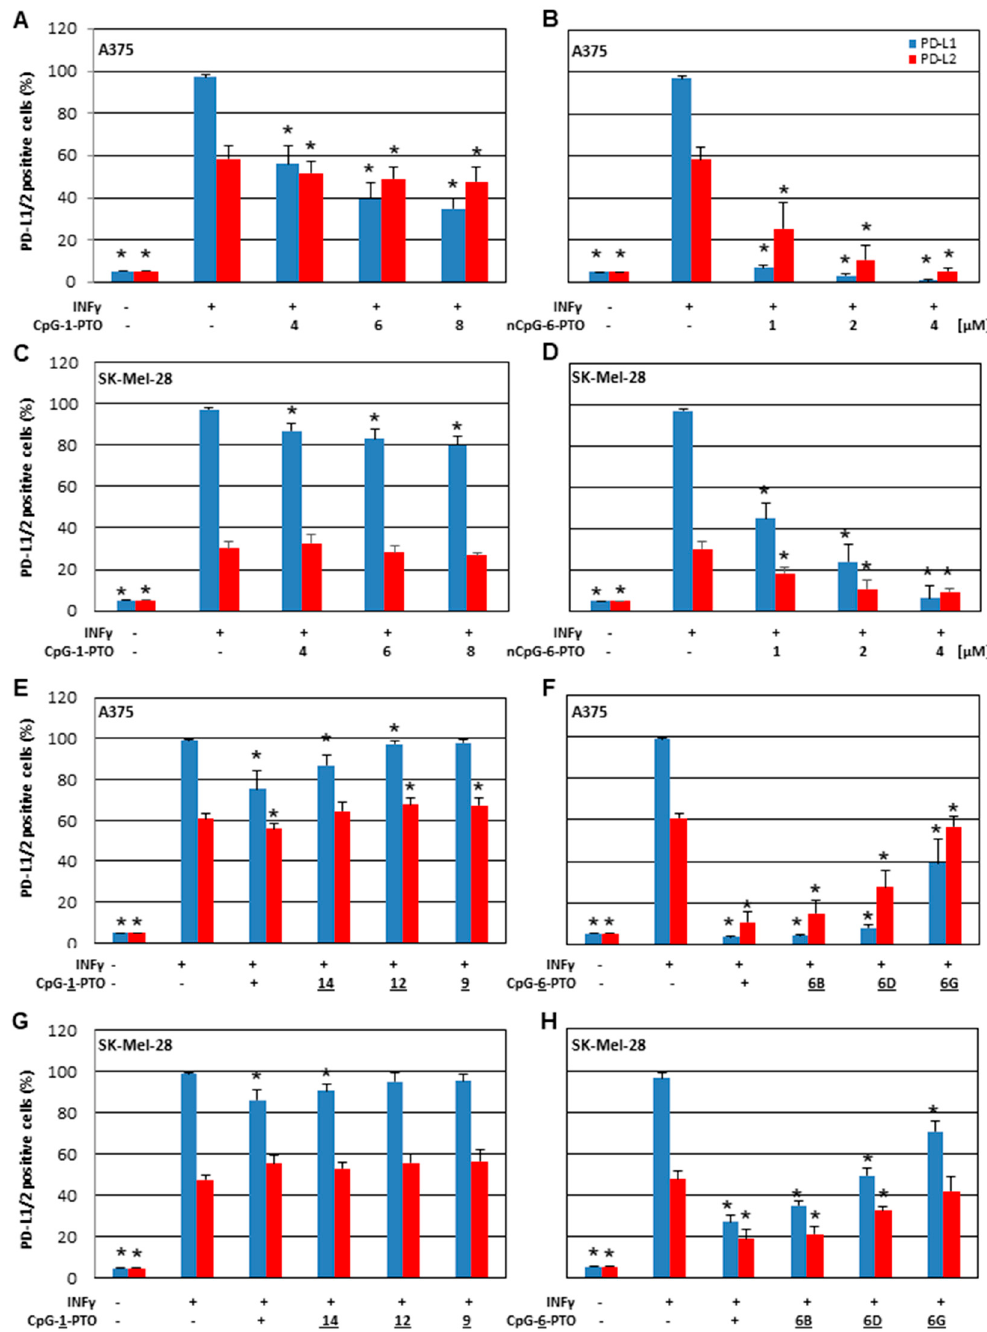
Figure 2. Suppression of PD-L1 and PD-L2 by nCpG-6-PTO and CpG-1-PTO—impact of concentration and molecule length. IFN γ -stimulated A375 cells were treated with increasing concentrations of ( A ) nCpG-6-PTO (1, 2 and 4 μ M) or ( B ) CpG-1-PTO (4, 6 and 8 μ M). Likewise, SK-Mel-28 cells were treated with increasing concentrations of ( C ) nCpG-6-PTO or ( D ) CpG-1-PTO. Moreover, the impact of ODN length was investigated. IFN γ -stimulated A375 cells were treated with ( E ) 4 μ M CpG-1-PTO and the referring deletion mutants (CpG-14/12/9-PTO) or ( F ) 4 μ M nCpG-6-PTO and the referring deletion mutants (nCpG-6B/6D/6G-PTO). Likewise, SK-Mel-28 cells were treated with ( G ) CpG-1-PTO or ( H ) nCpG-6-PTO and their referring deletion mutants. After 24 h expression, PD-L1 and PD-L2 were measured by FACS. Each bar represents the mean of 6 independent experiments. The standard deviations are indicated. Data were related to the referring positive control (IFN γ ). * p < 0.05.